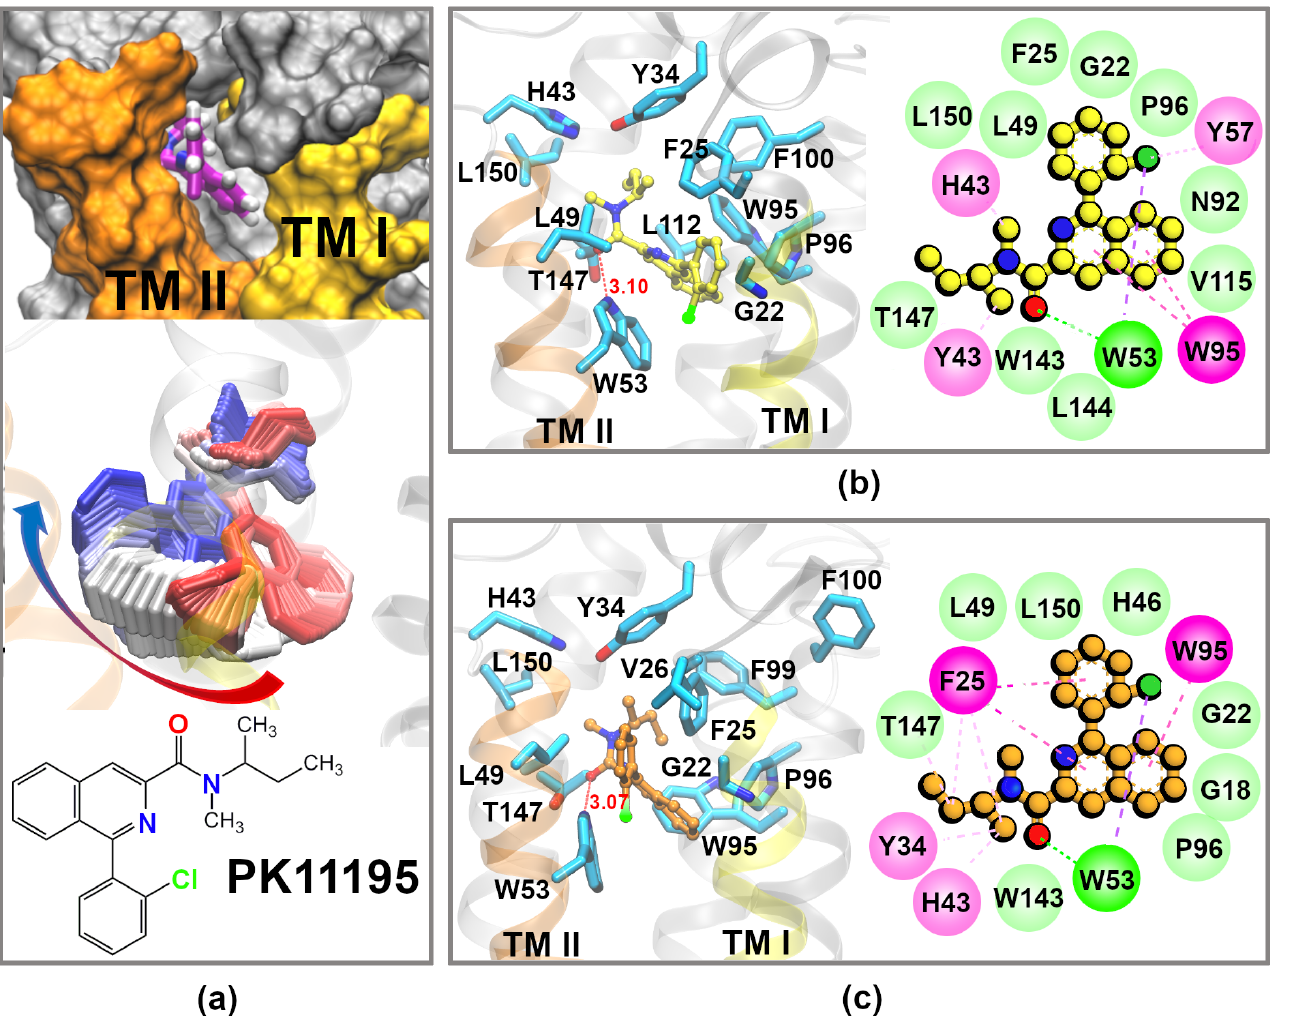
Figure 3. PK11195 binding interactions with the h TSPO model. ( a ) Top: Open access to the binding pocket between TM I and TM II of the h TSPO structural model that persists throughout the MD simulation. We do not observe other openings, nor the change in the LP I conformation. Center: PK11195 moves in the binding site of the h TSPO model from its initial state observed in the first 450 ns (red color) to the new pose (blue color, 450–1000 ns). The image of every hundredth frame is shown smoothed with a five frame window. Bottom: Chemical formula of PK11195. ( b , c ) 3D and 2D representations of the PK11195 binding pocket during the first 450 ns (top) and after the ligand movement, from 450 ns till the end of the MD run (bottom). 3D plots show PK11195 (yellow and orange balls and sticksrepresentation for 0–450 ns and for 450–1000 ns, respectively) and the residues binding it for more than 90% of the simulation time; the backbone and hydrogen atoms were omitted for clarity reasons. F100 was kept in ( c ), despite that it does not bind PK11195 anymore, to show the change in its side chain conformation. The most constant interactions, formed for more than 75% of the simulation time between PK11195 and the h TSPO model, are shown in the 2D plots obtained by the Discovery tool [62]. Legend: green circles—hydrogen bonds, light green circles—VdW interactions, light pink circles— π -alkyl, and dark pink circles— π - π interactions. PK11195 is additionally bound through VdW, hydrophobic, or stacking interactions